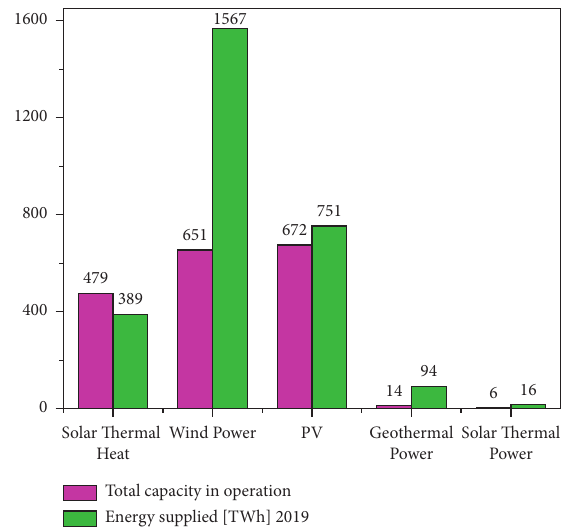
Figure 1: Global capacity in operation (GW) and energy supplied (TWh) [29].